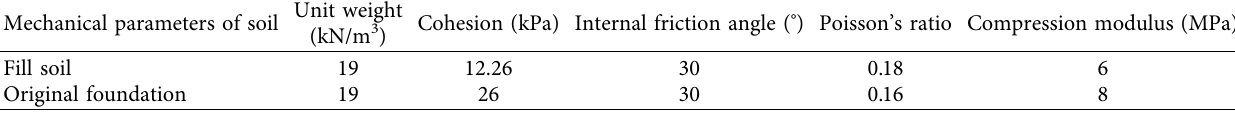
Table 1: Parameters of multistage fill slope.